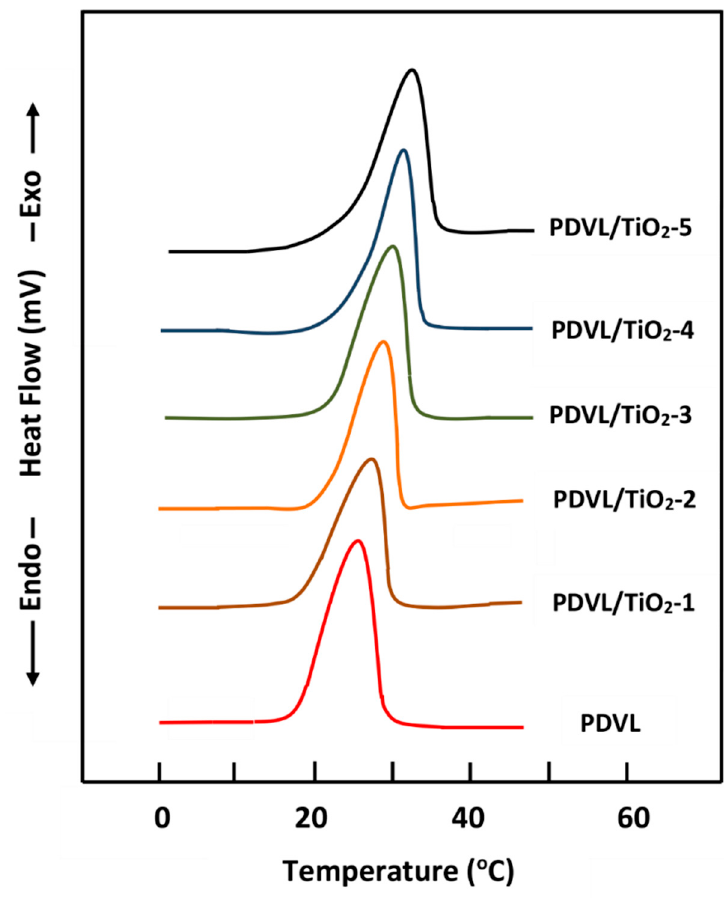
Figure 5. DSC thermograms of pure PDVL and PDVL/TiO 2 hybrid materials containing different TiO 2 contents taken in the cooling mode with a cooling rate of 20 °C·min − 1 .